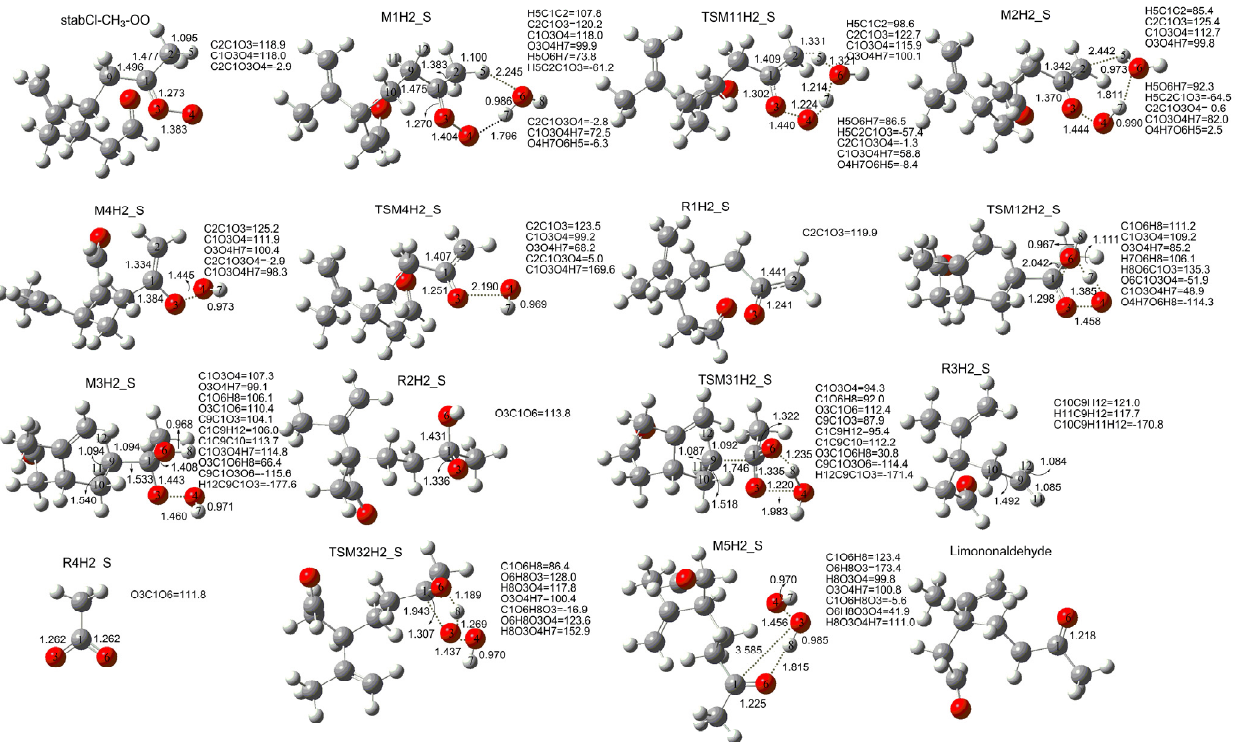
Figure 2. Geometries of the stationary points in the stabCI-CH obtained at the B3LYP/6-31G(d,p) level of theory. Bond lengths and intermolecular distances are given in